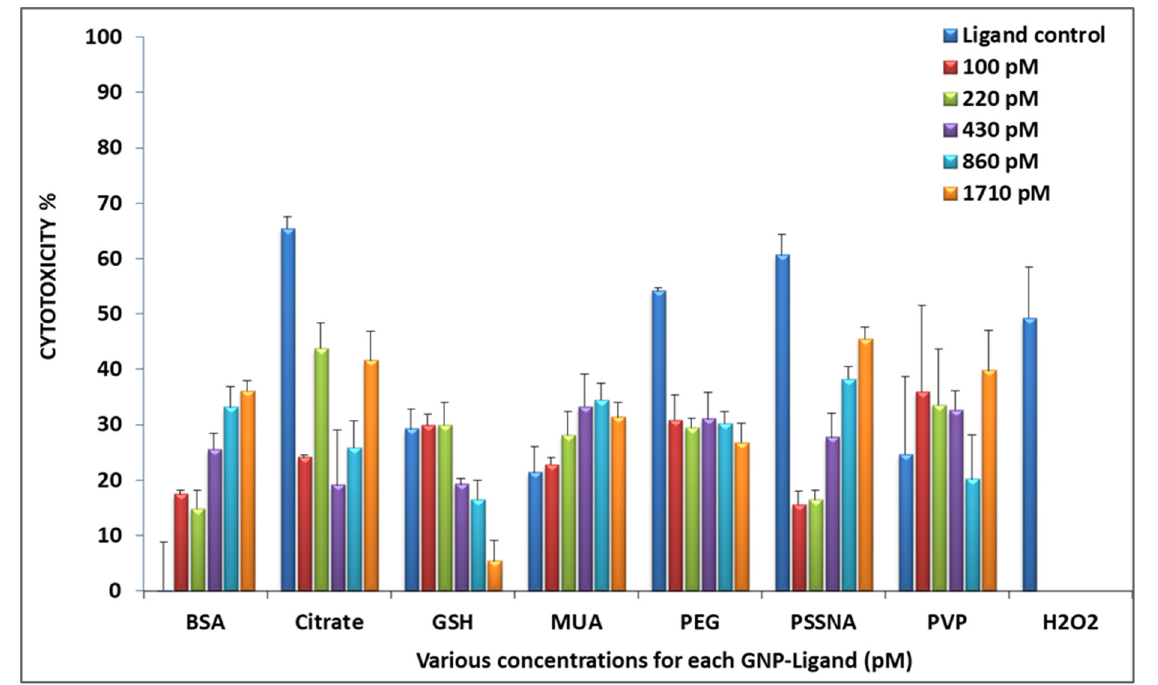
Figure 3. Cytotoxicity of the GNP-ligands at a range of concentrations on HepG2 cells (the ligand control contained ligand only in the same concentration as the highest concentration used, no GNP present). This data is based on an average of triplicate readings obtained for each concentration.